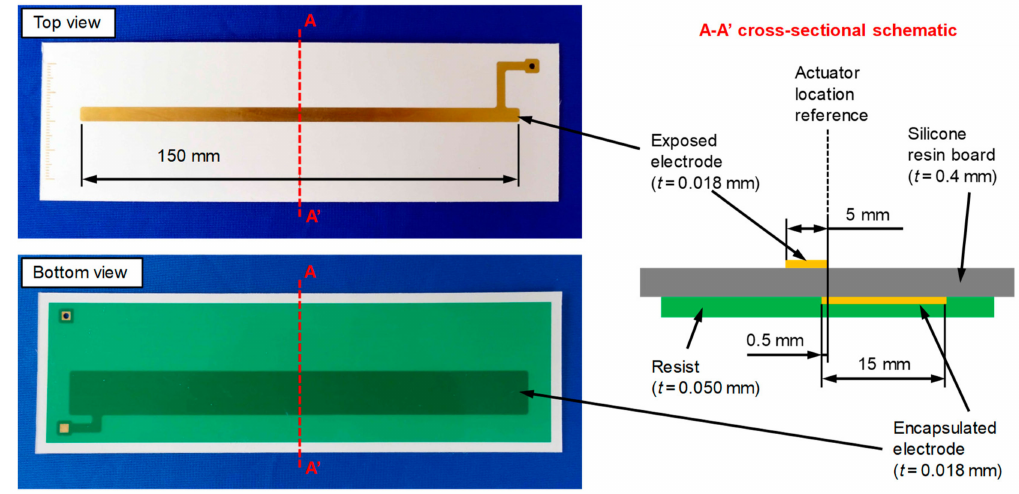
Figure 4. Photographs of top- and bottom-views and cross-sectional schematic of plasma actuator.